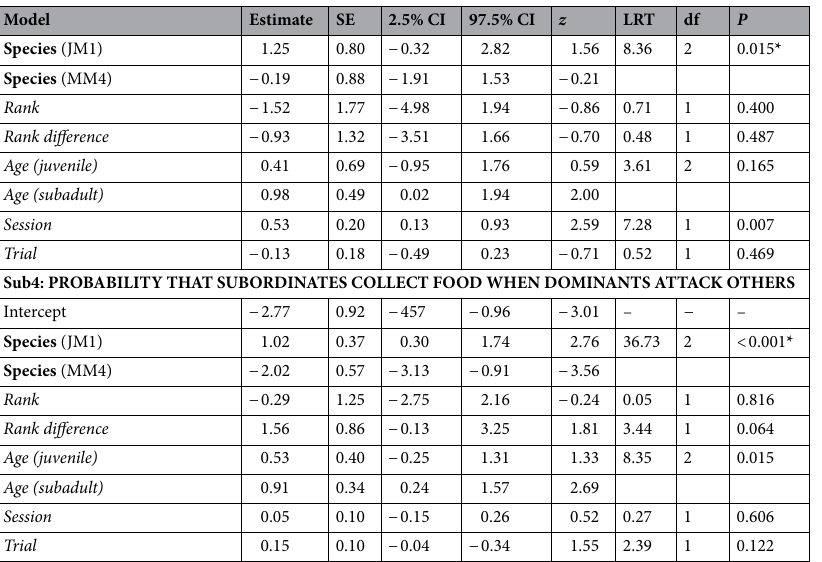
Table 2. Results of the models run, including estimates, standard errors (SE), confidence intervals (CIs), z values ( z ), likelihood ratio tests (LRT), degrees of freedom (df), and p values for each test and control predictor (in parentheses, the reference category). Significant test predictors are in bold, control predictors in italics. Session and trial numbers were z -transformed prior to analysis. All models included subject identity as random effect. The asterisks denote significant p values for the test predictors. All models had a binomial distribution.